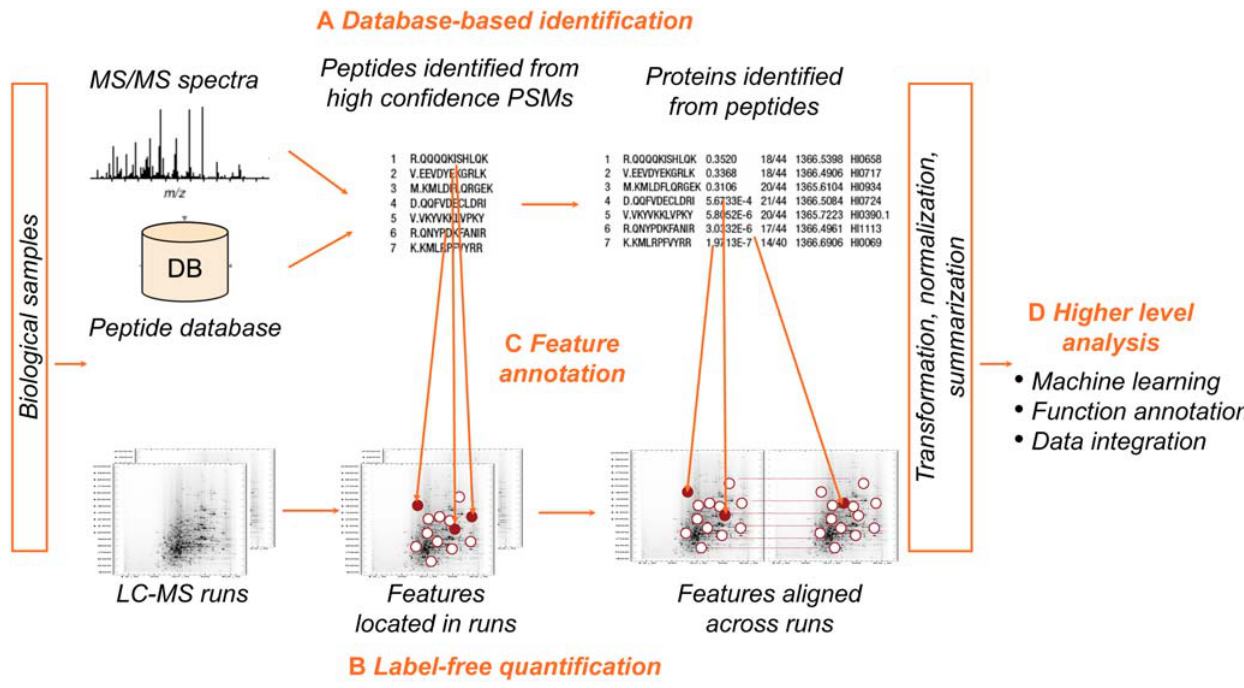
Figure 2. Example of a proteomic workflow using database-based identification and label-free quantification. (A) Identification of MS/ MS spectra. Experimental spectra are compared to peptides in a database, and the best-scoring PSMs are reported while controlling the FDR. Protein sequences are identified from the peptides. (B) Label-free quantification. Features in LC-MS runs (shown with circles) are located, quantified, and aligned across runs. (C) LC-MS features are annotated with peptide sequences when identifications are available (shown with filled circles). The annotations are used to optimize the alignment of features across runs. The list of quantified, identified, and aligned features is then subjected to transformation, normalization, and summarization. (D) The list of features is used as input to machine learning, functional annotation, and data integration steps.